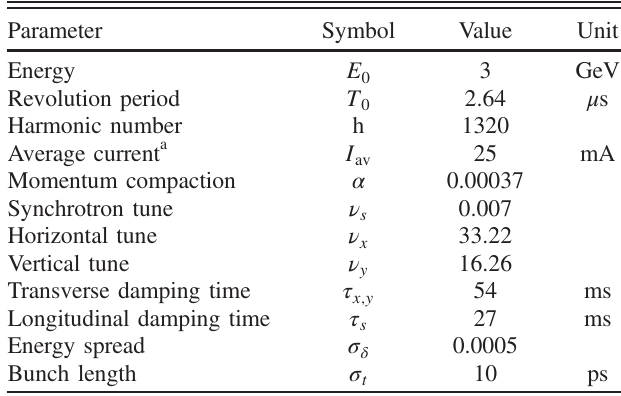
TABLE I. Parameters for NSLS-II bare lattice.